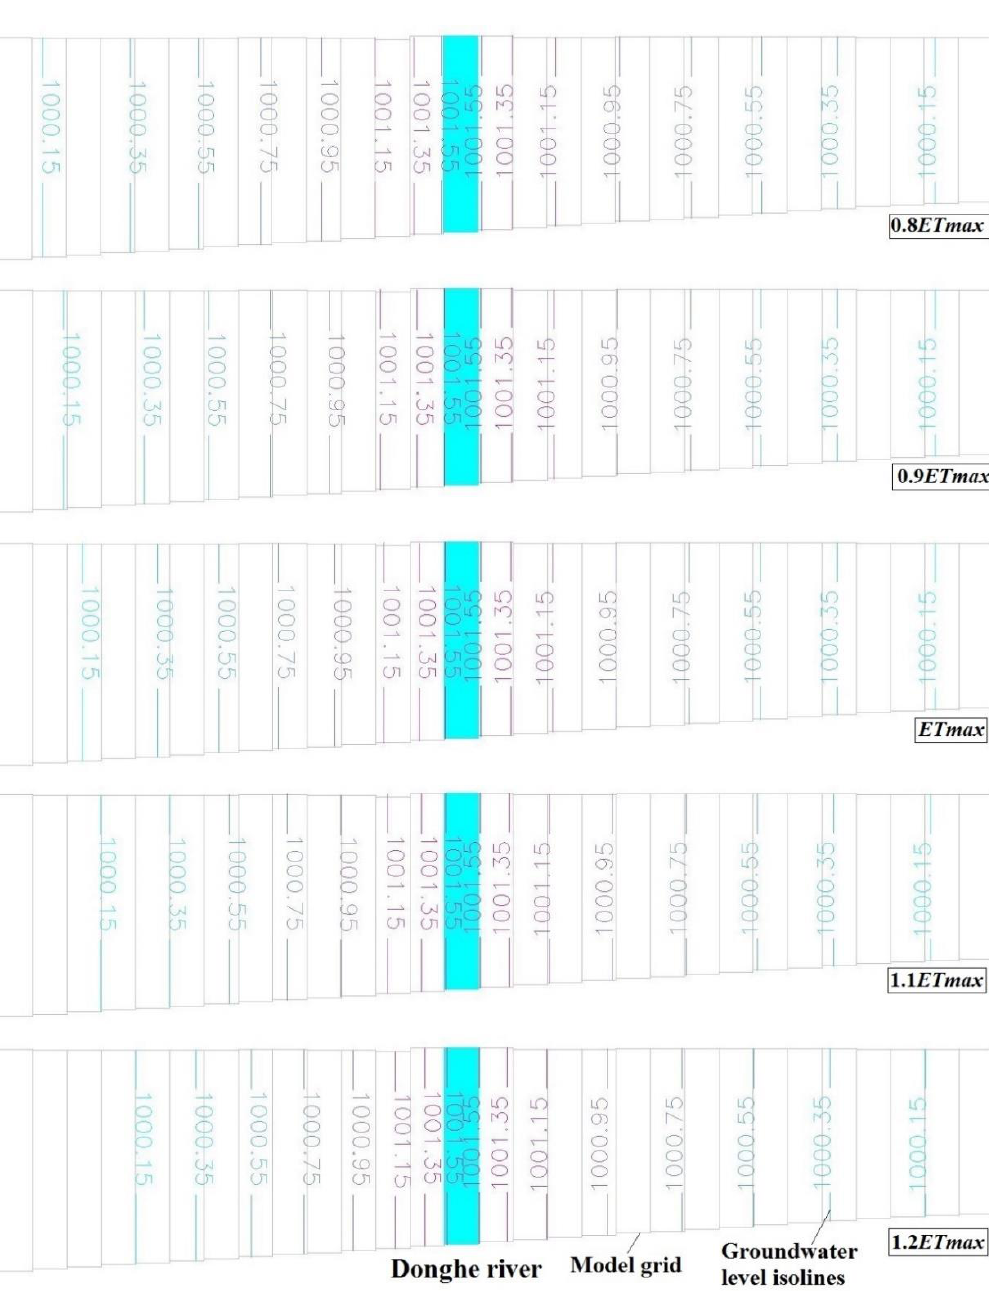
Figure 7. Groundwater levels under different values of the maximum evapotranspiration rate (cross-section from west to east in the middle of the simulated area).